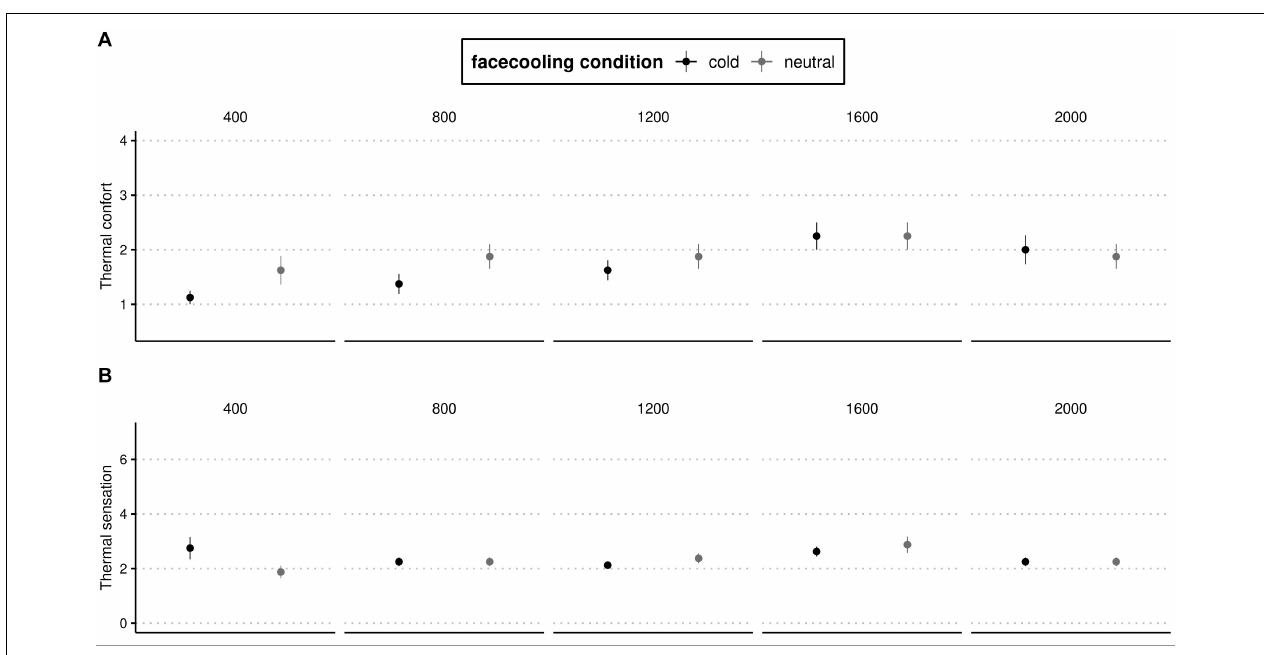
FIGURE 2 | (A) Rating of thermal sensation and (B) Rating of thermal comfort at different distances with the Cold water-cooling and Neutral water cooling. Mean values and SD are shown.